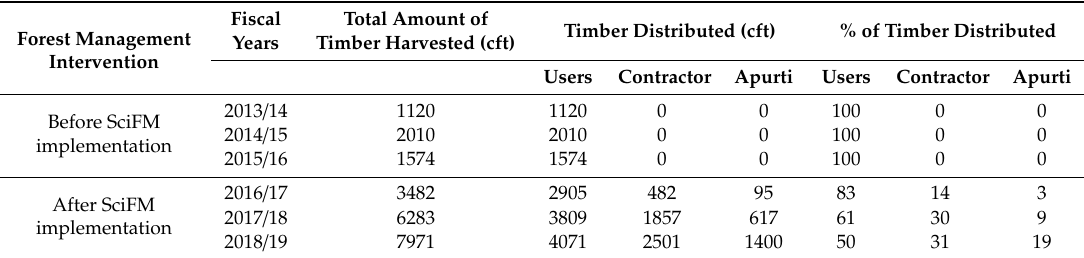
Table 2. Timber distribution pattern before and after SciFM implementation at the CFUG